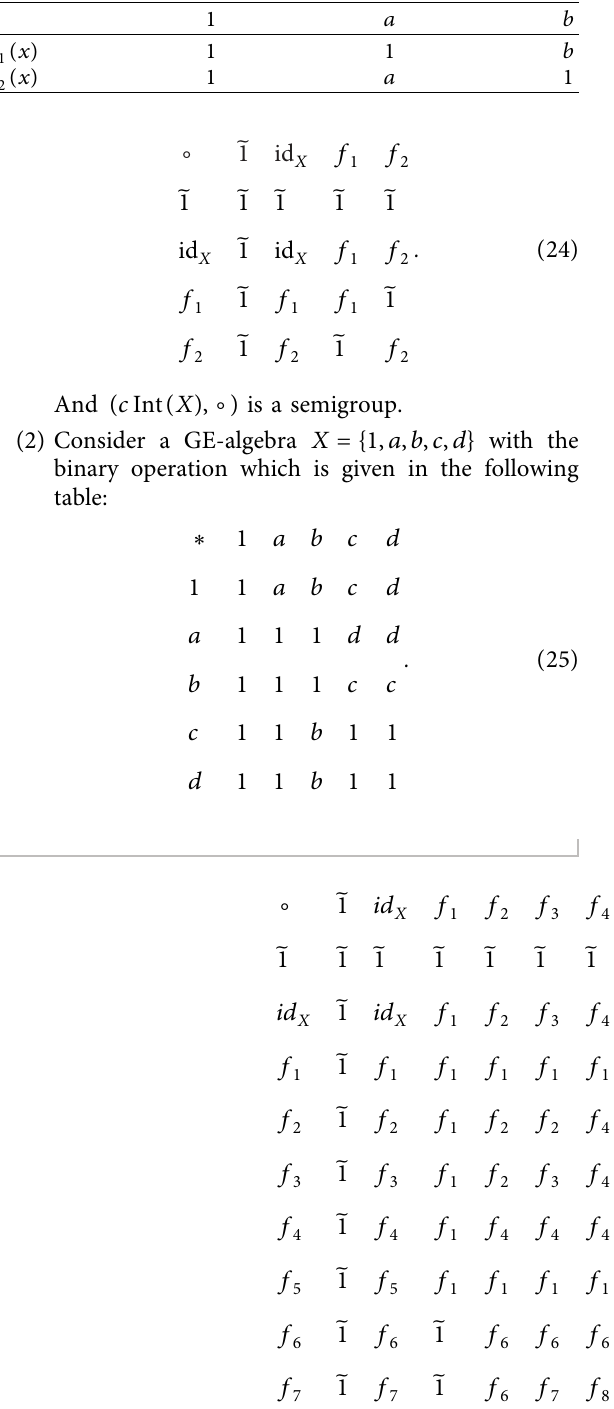
i � 1 , 2. Table 2: Self-maps f i ,